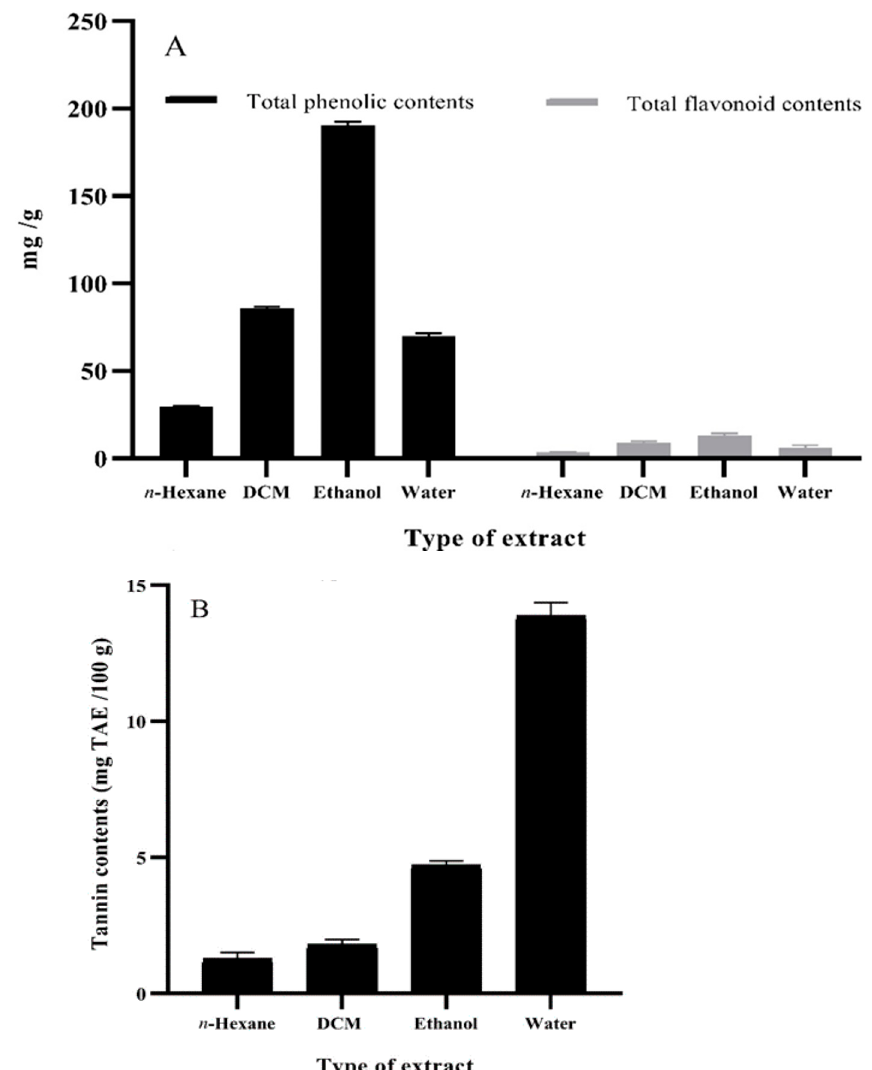
Figure 1. Phytochemical content of different solvent extracts of basil ( O. basilicum ; 2.5 mg/mL). ( A ) Total phenolic (mg GAE/g) and total flavonoid content (mg QE/g). ( B ) Tannin content (mg TAE/100 g). Values are means ± S.D. GAE, gallic acid equivalent; QE, quercetin equivalent; TAE, tannic acid equivalent; DCM,